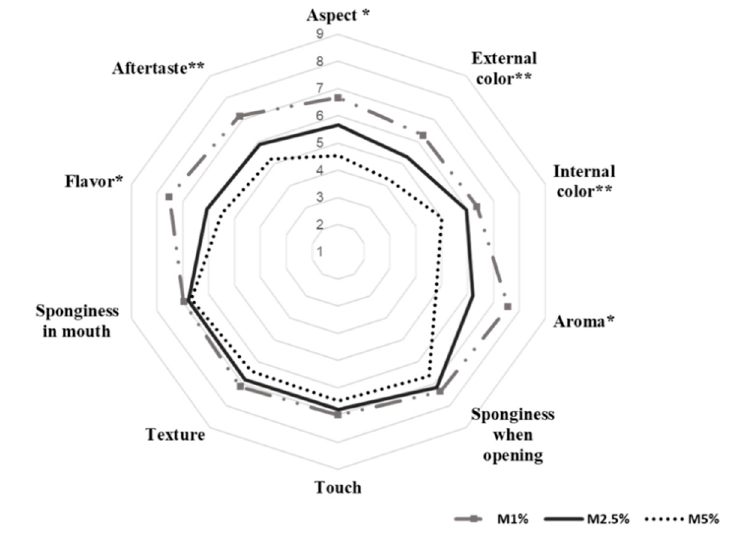
Figure 1. Hedonic scores of cupcakes formulated with moringa. (* significant level > 95%, significant level >